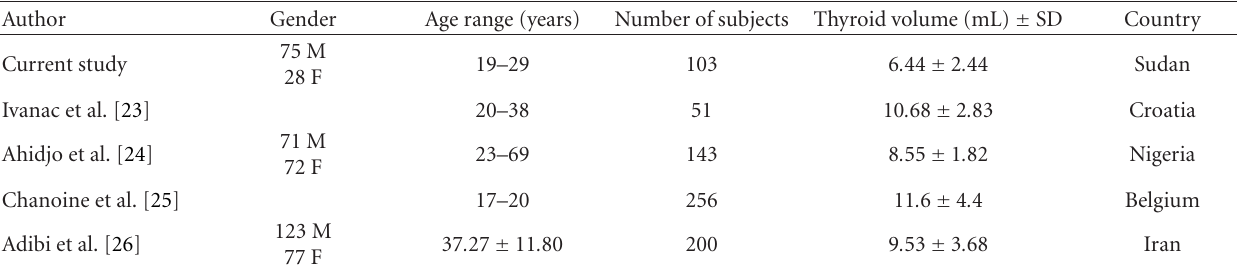
Table 2: Comparison of thyroid volume